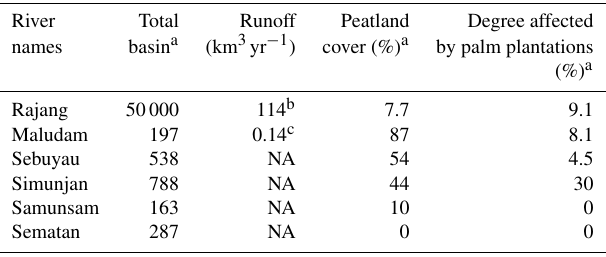
Table 1. The physico-geographical parameters of sampled